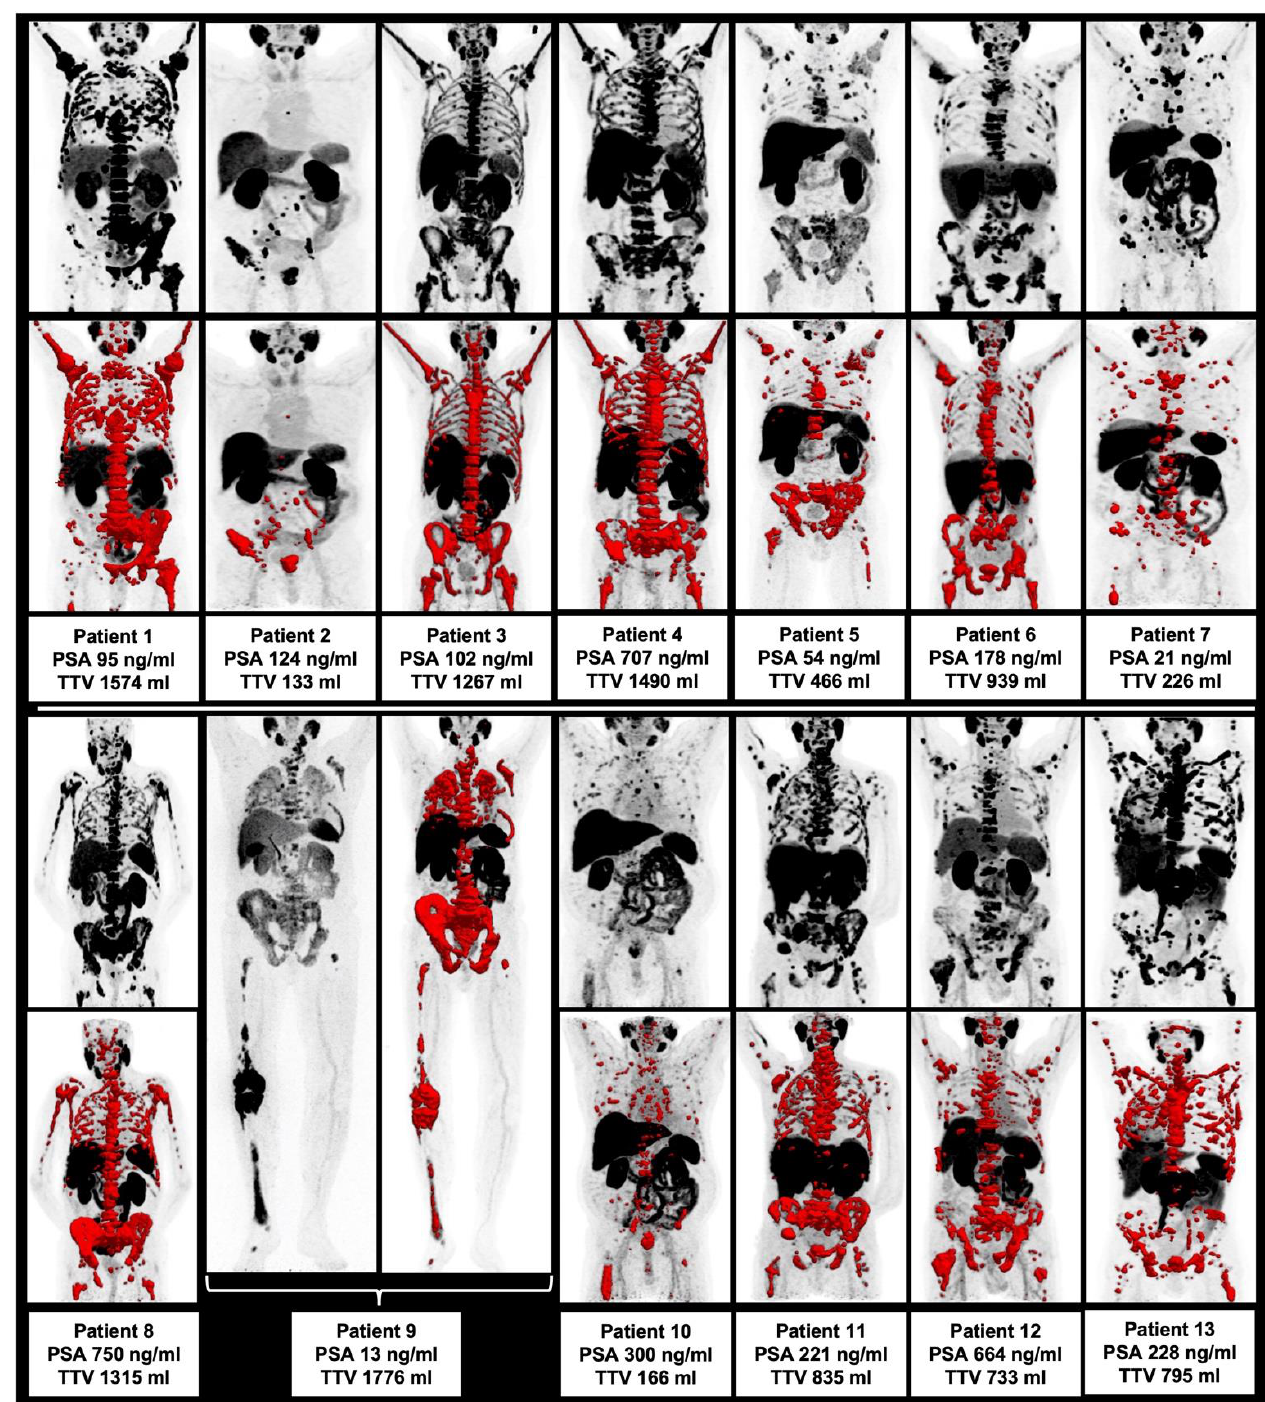
Figure 1. Overview of all included patients with maximum intensity projection (MIP) and included TTV